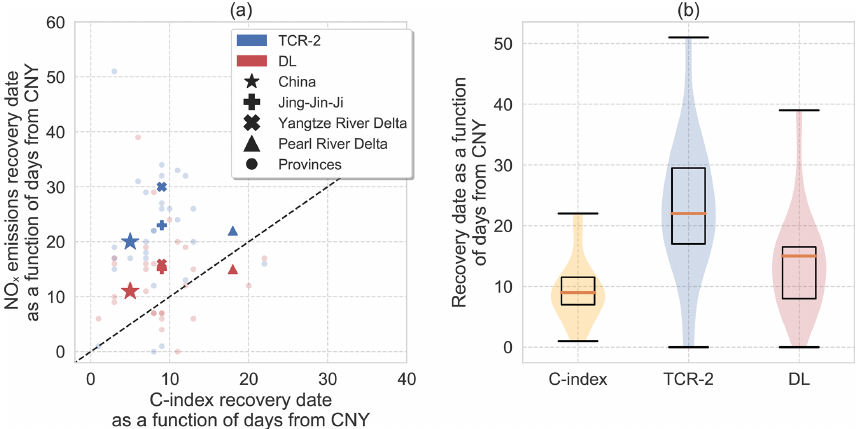
Figure 10. Comparison of the timing of the recovery of the NO x emissions and Baidu C-index data back to 50% of the averaged values 5d before the CNY in 2019. (a) The scatter plot of NO x emission recovery dates versus the C-index recovery dates. Each circle represents a province and special markers correspond to the larger regions as indicated by the legend. (b) Box whisker plots and the normalized distribution of the recovery dates for the C-index, TCR-2 NO x emissions, and the DL-based NO x emissions, calculated based on all provinces in China.